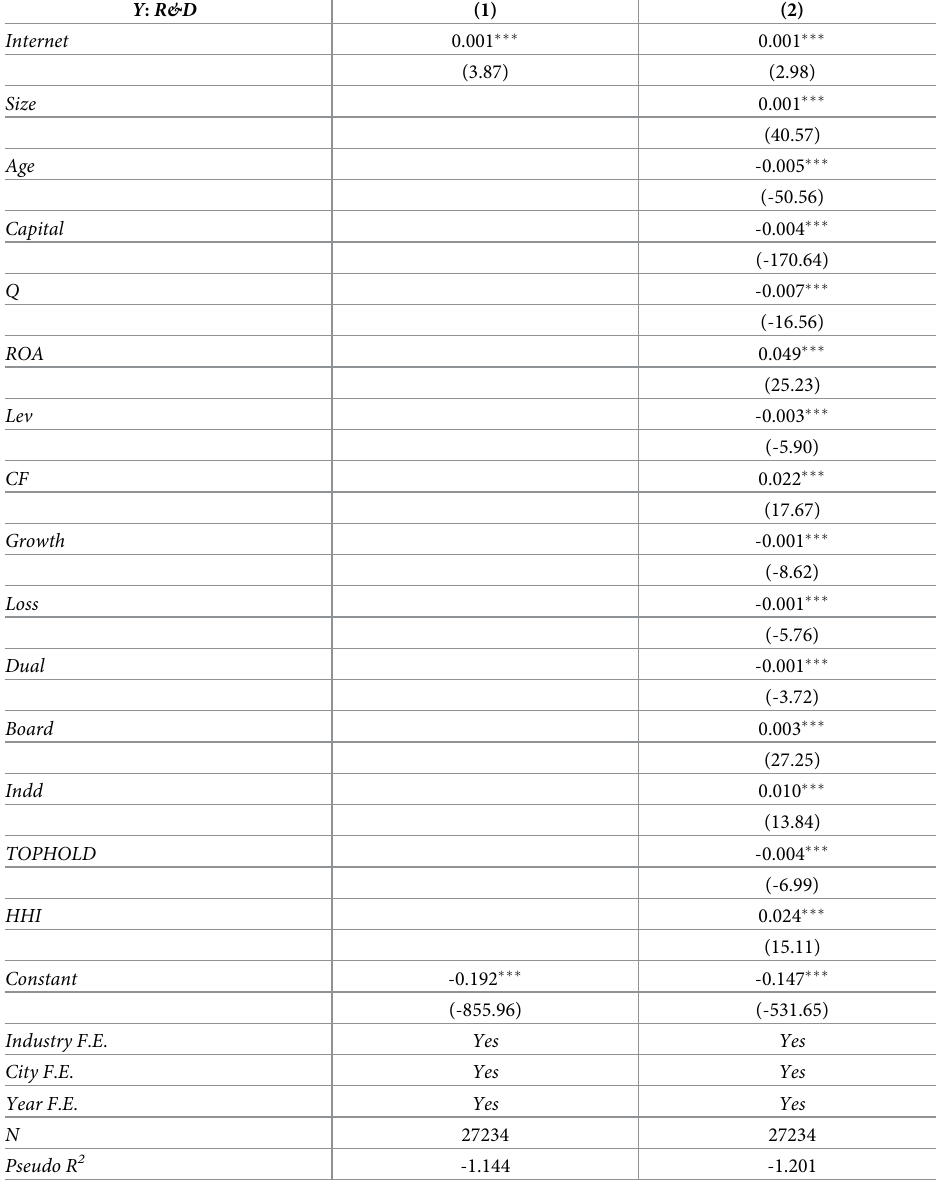
Table 2. The impact of Internet penetration rate on corporate